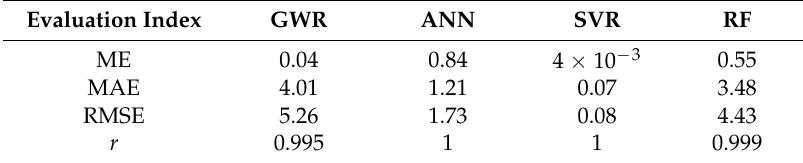
Table 4. Performance evaluation of the GWR, ANN, SVR, and RF models.